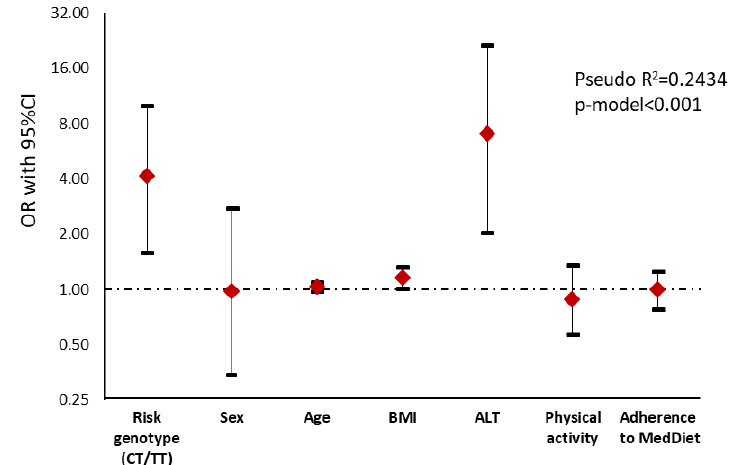
Figure 2. Graphical display of the Odds Ratio (OR) (95% confidence interval) of the logistic regression analysis showing the association between steatosis degree measured by ultrasonography (0 = no or mild steatosis vs. 1 = moderate and severe steatosis) and genotype risk in NAFLD subjects. Notice that the y -axis is on a log scale. ALT, Alanine Aminotransferase; BMI, Body Mass Index.